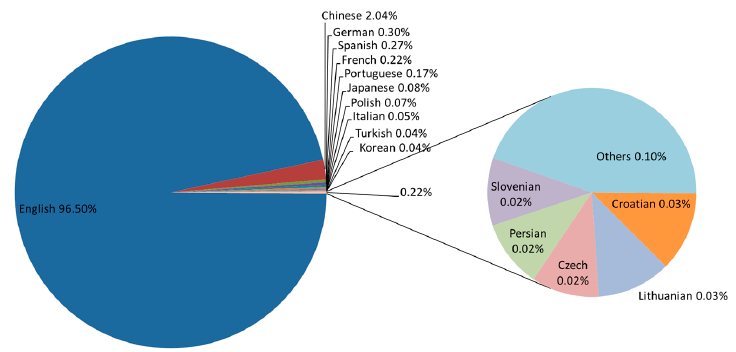
Figure 2. Chart representation of publications based on the language used.